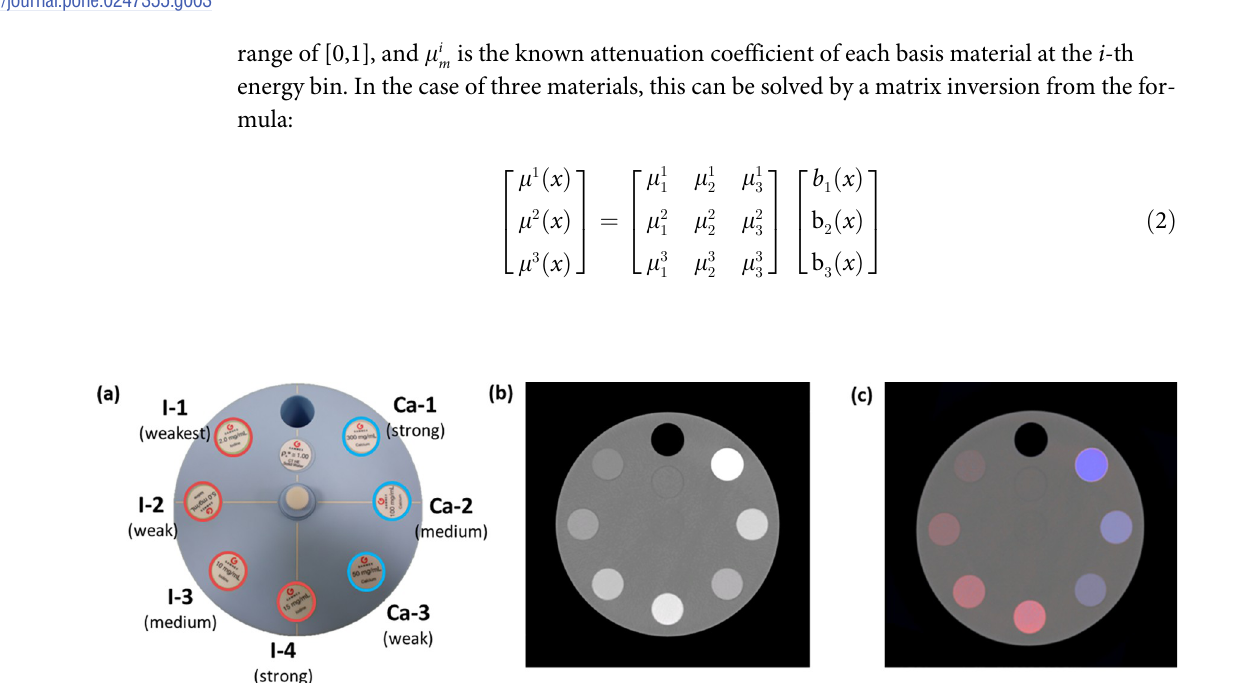
Fig 4. (a) Gammex phantom with iodine and calcium at various concentrations: Iodine (I-1: 2.0 mg/mL, I-2: 5.0. mg/mL, I-3: 10 mg/ mL, I-4: 15 mg/mL) and calcium (Ca-1: 300 mg/mL, Ca-2: 100 mg/mL, Ca-3: 50 mg/mL). (b) The single channel image for the 30 to 140 keV energy level (display window: W/L = 1000/0 HU): Iodine (I-1: 51 HU, I-2: 128 HU, I-3: 268 HU, I-4: 402 HU) and calcium (Ca-1: 899 HU, Ca-2: 333 HU, Ca-3: 195 HU). Calcium and iodine are difficult to distinguish. (c) An overlaid image that clearly separates iodine and calcium using images of the three energy levels (bin 1, bin 2, and bin 3) (pink: iodine, blue: